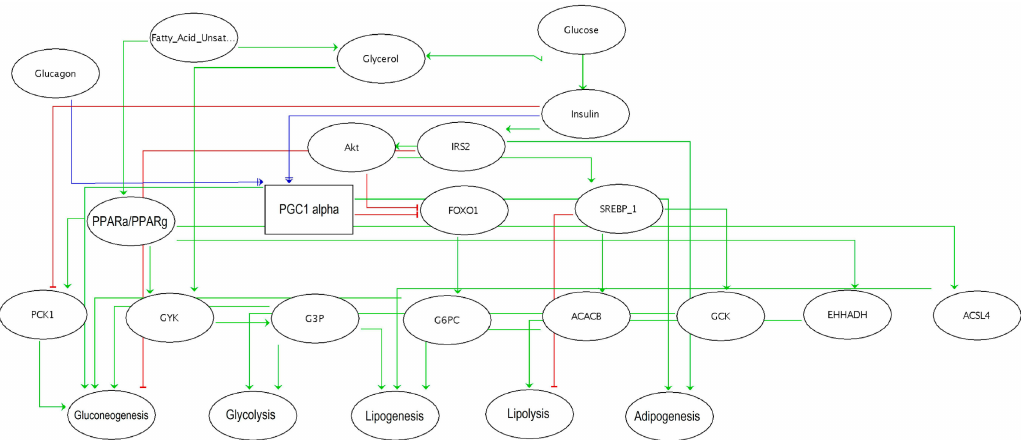
Figure 6. Computational modeling predicts that dynamism in genes expression leads to specific cell metabolic phenotypes. A Boolean modeling of glycolysis, gluconeogenesis, lipolysis, lipogenesis,